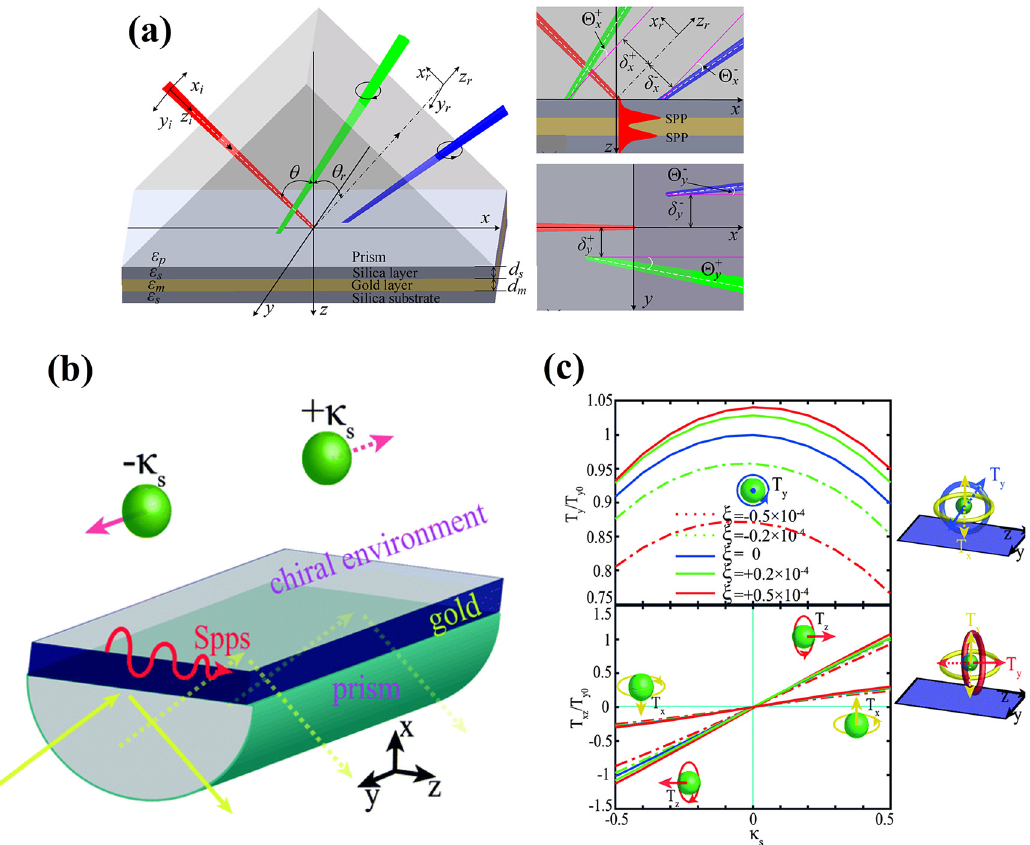
Figure 5: a, Illustration of the enhancement of PSHE shifts with the LRSPR structure [94]; Reproduced with permission. Copyright 2018, Elsevier. b, schematic of SPP-assisted chiral enantiomer discrimination and separation [95]; c, left, the optical torque of chiral particles with different chiral intensities; right, the schematic diagram of chiral particle motion caused by the optical force (arrow) and torques (ring) [95]. Reproduced with permission. Copyright 2019, Owner Societies.